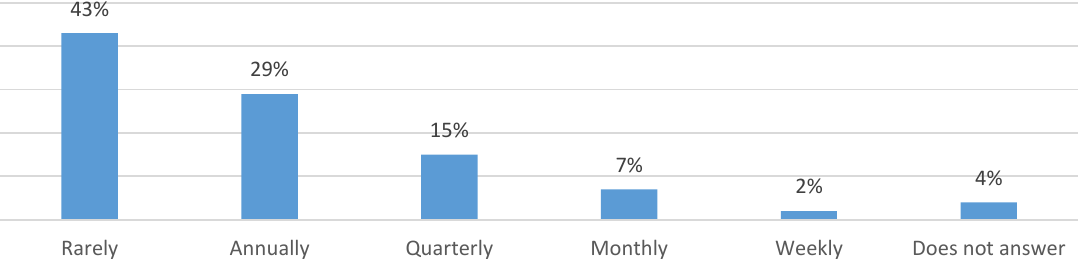
Figure 1. Frequency of purchase or receipt as present of luxury